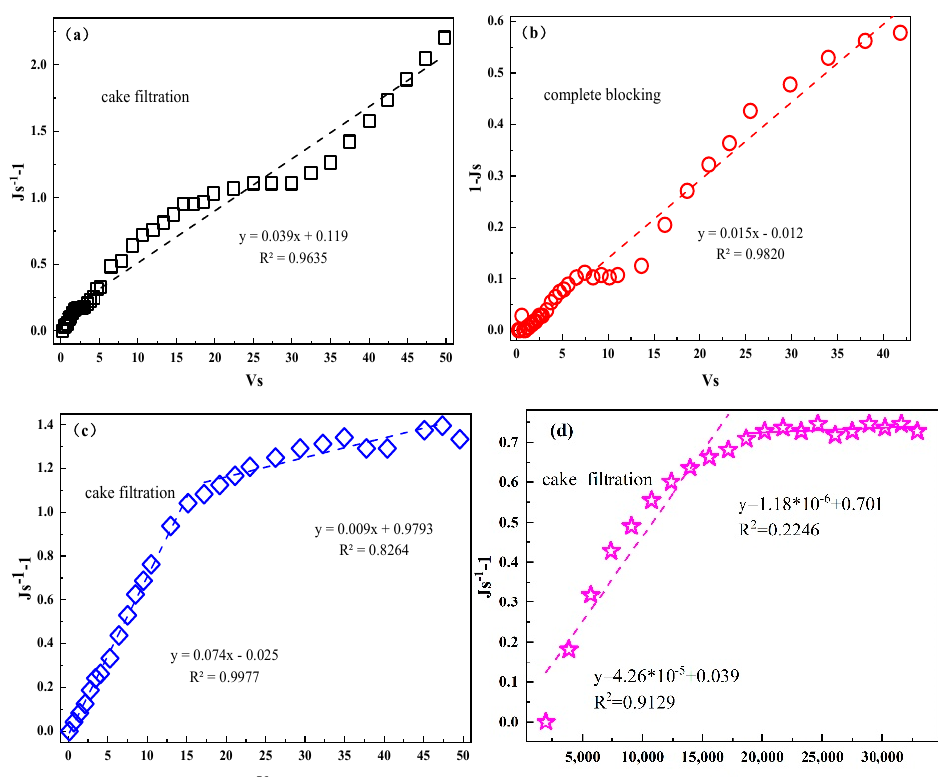
Figure 8. The membrane-fouling models with different initial fluxes were fitted with separate membrane filtration conditions: ( a ) the model with an initial flux of 30 L/(m 2 · h); ( b ) the model with an initial flux of 60 L/(m 2 · h); ( c ) the model with an initial flux of 90 L/(m 2 · h); ( d ) membrane-fouling model fitting for the combined process.